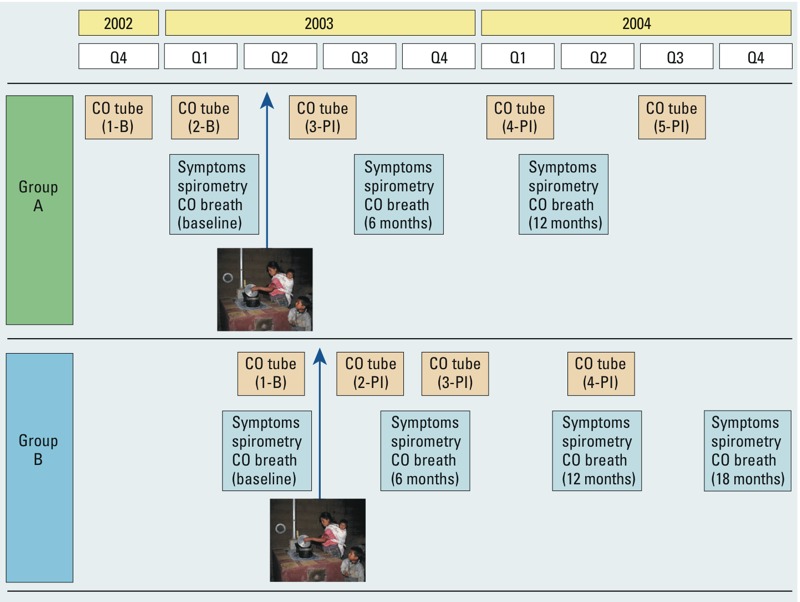
Timing of assessment of personal exposure using CO tubes and of symptoms, lung function, and CO breath, in relation to the installation of the chimney stove, for recruitment groups A and B. Abbreviations: B, baseline; PI, postintervention; Q1–Q4, yearly quarters (3-month intervals). Number of CO tubes is listed (1–5).